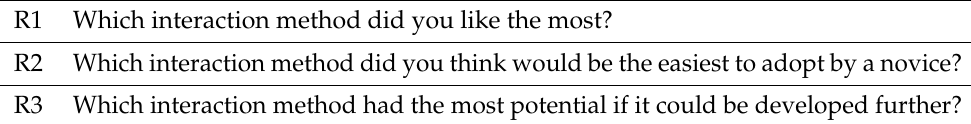
Table 3. The questions R1 to R3 that were asked to rank the interaction